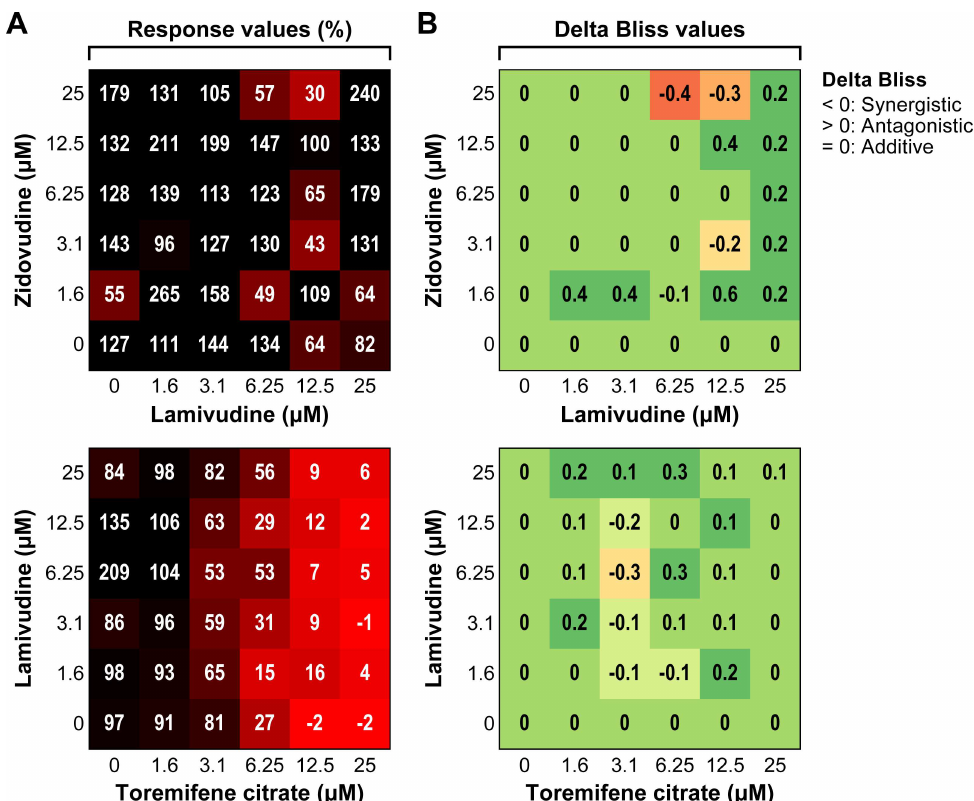
Fig 5. Antiviral activity of drug combinations against Makona variant of Ebola virus. Dose matrix (6 x 6) evaluation of two drug combinations, lamivudine/toremifene citrate and lamivudine/zidovudine. Huh 7 cells were pre-treatedwith drug combinations for 1 h and inoculated at a multiplicityof infection(MOI) of 0.1 for 72 h. (A) The heat map of percent response shows the antiviral activity of each combination (100% corresponds to “no activity”). (B) The Δ Bliss plot indicateshow much a combination effect differs from the additive effect as determined by the Bliss model. The experimentwas run once with triplicate wells per dose (mean ± SD; n = 3). Δ Bliss = 0 (additiveeffect); Δ Bliss < 0 (synergistic effect); Δ Bliss > 0 (antagonistic